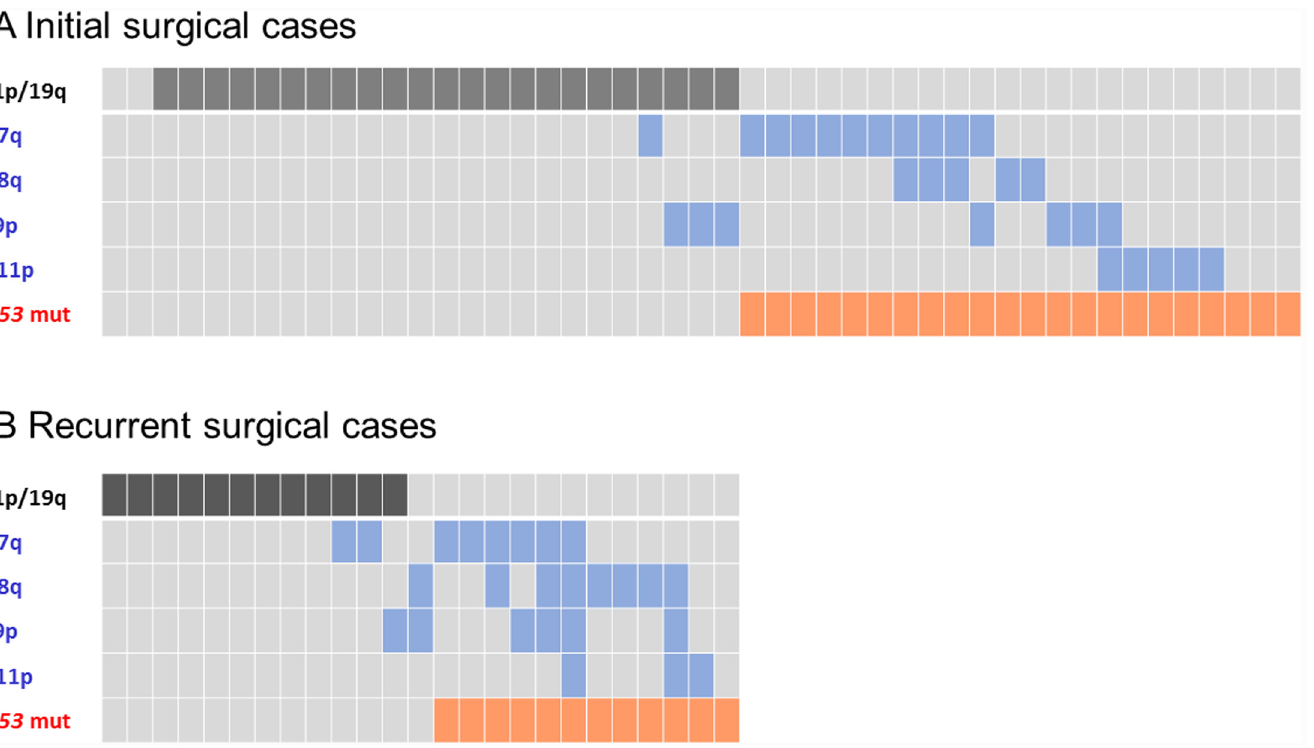
Fig 3. The correlation between TP53 mutations and the CNAs − 1p/19q, +7q, +8q, − 9p, and − 11p in IDH mutant gliomas. A comparison between (A) primary (n = 47) and (B) recurrent disease (n = 24). The CNA − 1p/19q represents a favorable prognostic marker; the CNAs +7q, +8q, − 9p, and − 11p represents unfavorable prognostic